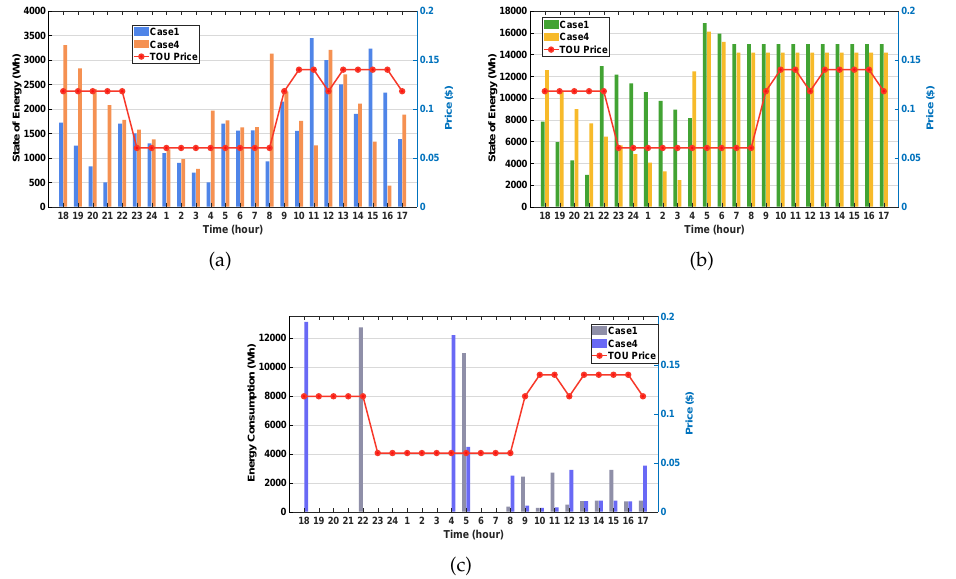
Figure 7. Performance comparison between Case 1 and Case 4. ( a ) SOE of the ESS; ( b ) SOE of the EV; ( c ) net consumption of